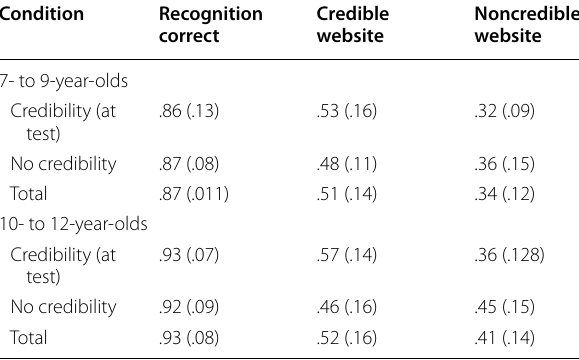
Table 3 Mean (standard deviation) recognition and source accuracy scores from Study 2 by age and credibility